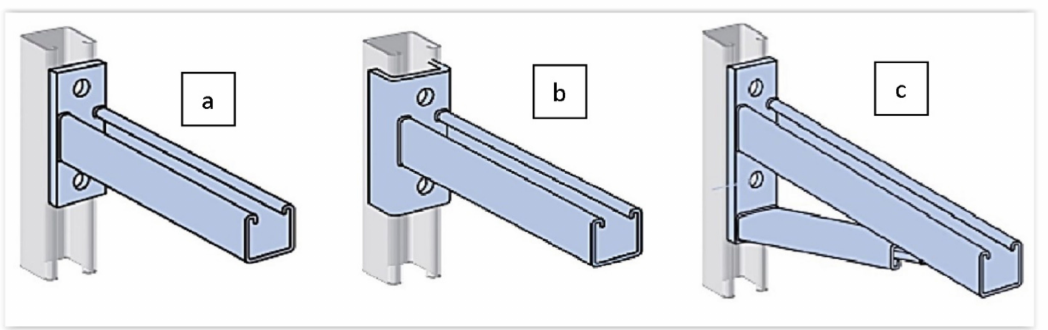
Figure 1. Examples of construction solutions of cantilever brackets designed based on more than one component: ( a ) one profile based design, ( b , c ) two or more profiles based designs.